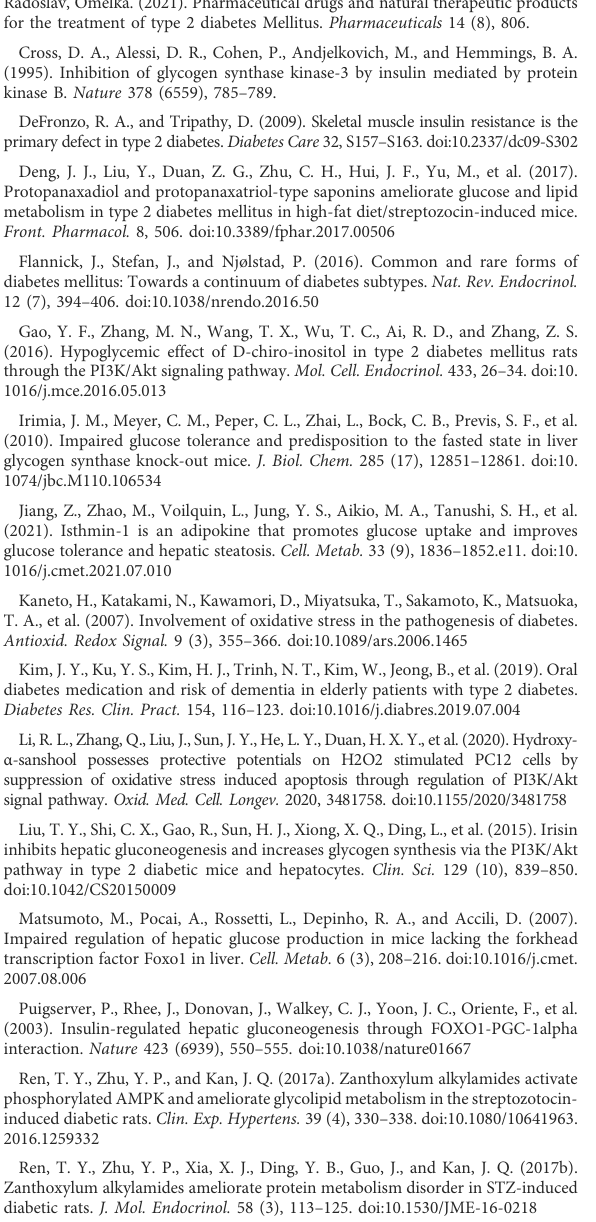
SUPPLEMENTARY FIGURE S1 (A) HASreducedthewaterintakeofHFD+STZmice. (B) HASreducedthe foodintakeofHFD+STZmice. (C) Fastingbloodglucose(FBG)ofT2DM mice per